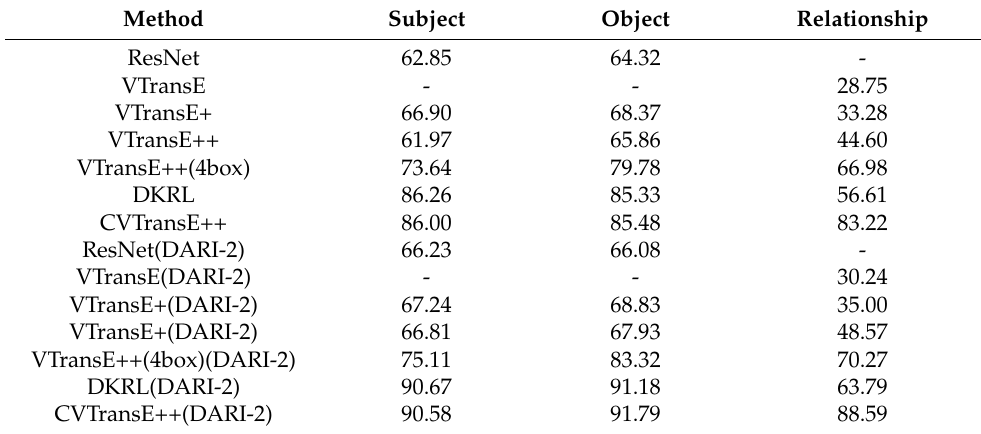
Table 1. Experimental